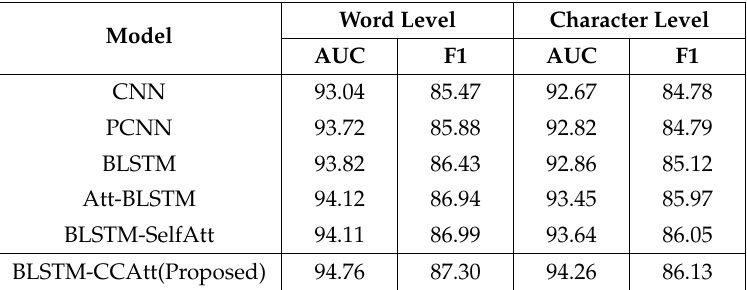
Table 3. AUC and F1-scores of different